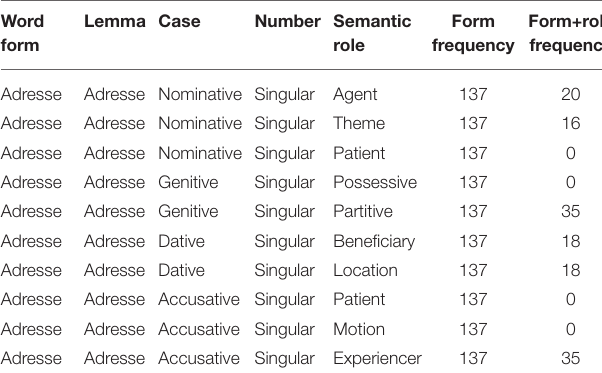
TABLE 10 | Example of simulated frequencies for combinations of case and semantic role for the word form